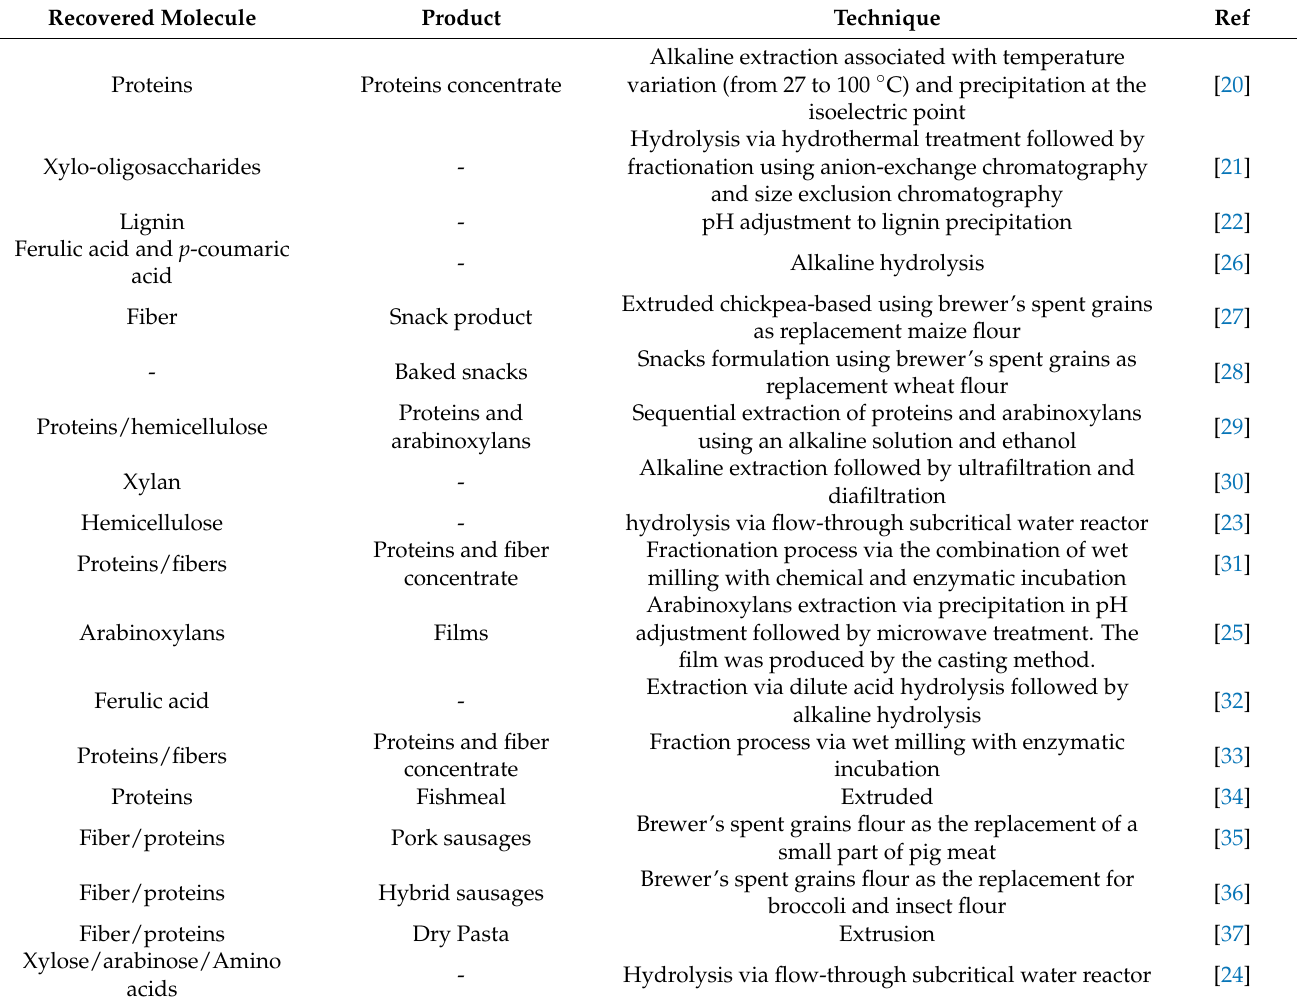
Table 1. Studies about used compounds from brewer’s spent grains attractive to the food